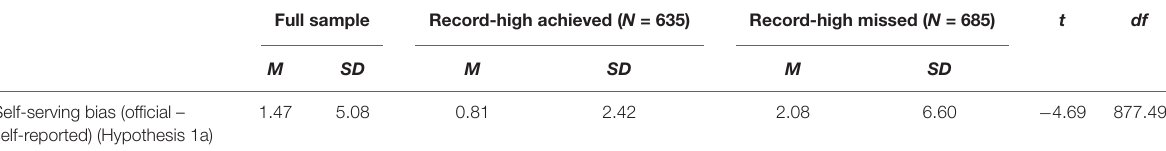
TABLE 5 | Results of independent sample t -test with unequal variance assumption.